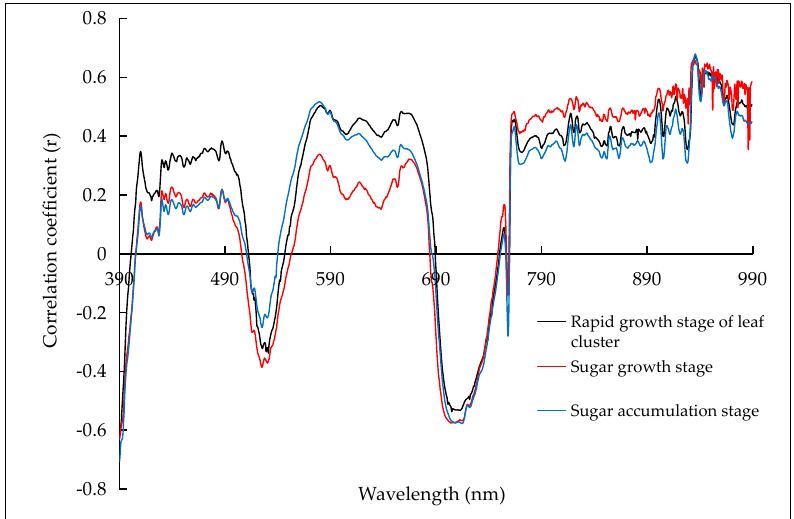
Figure 6. The Pearson correlation coefficients (r) between the spectral wavelengths and the measured above-ground biomass (AGB).